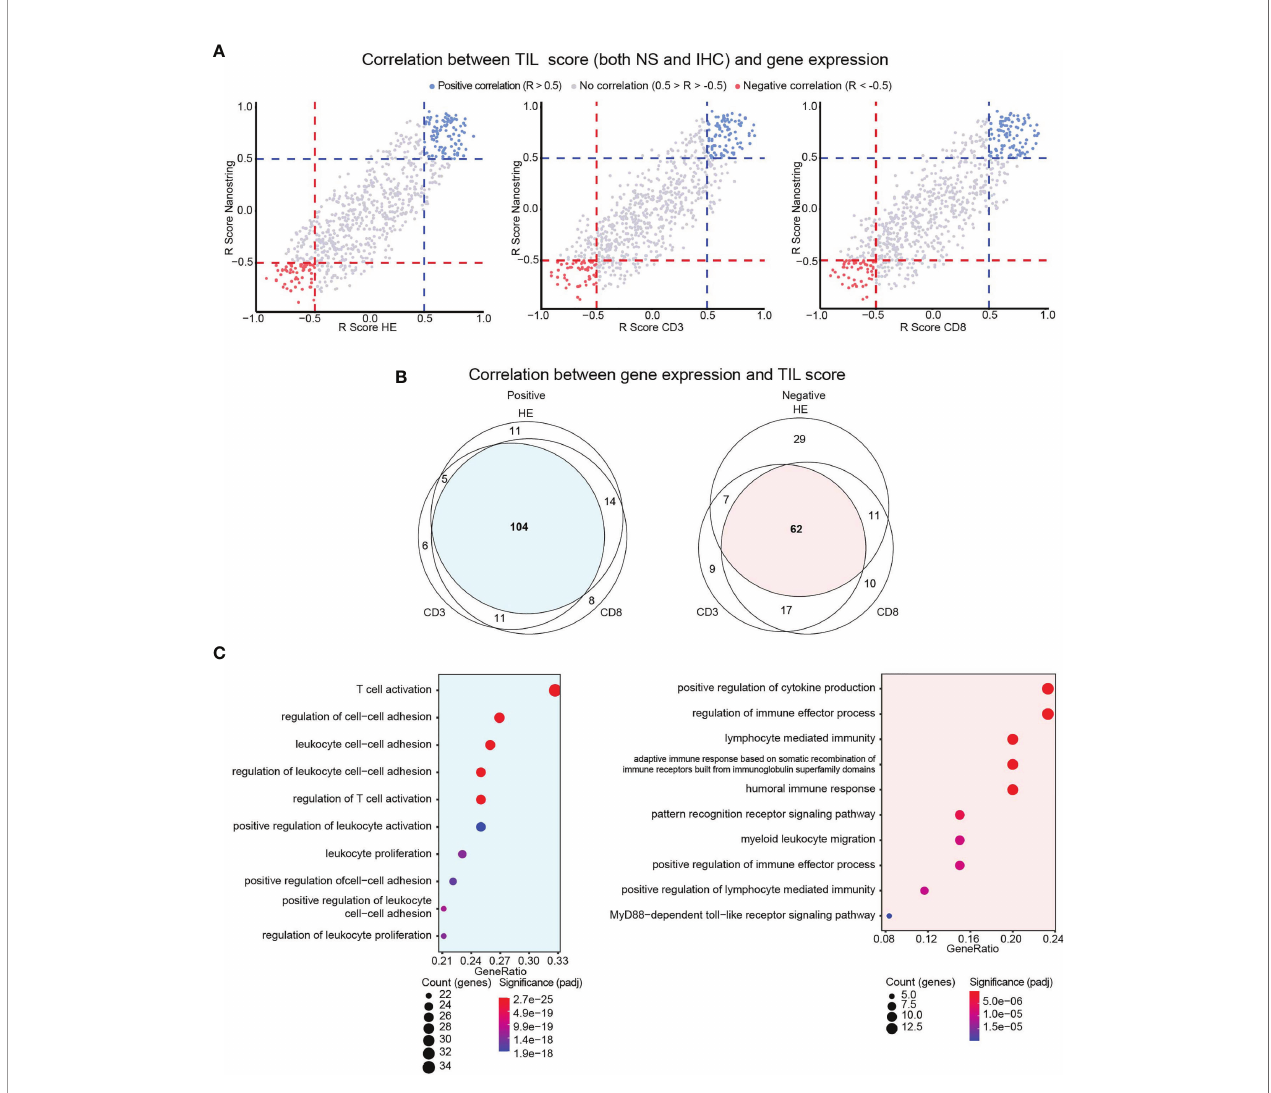
FIGURE 5 | Identi fi cation of genes directly or inversely correlated with TIL scores. (A) Scatter plot showing correlation ( R scores) between gene expression and TIL scores for TIL-HE, TIL-CD3, and TIL-CD8 methods. (B) Venn diagram showing overlap in directly or inversely correlated genes between different TIL-scoring methods. (C) Gene ontology analysis showing functions in which communal genes are involved. Data information: Positive correlation de fi ned as R > 0.5, negative correlation de fi ned as R < −